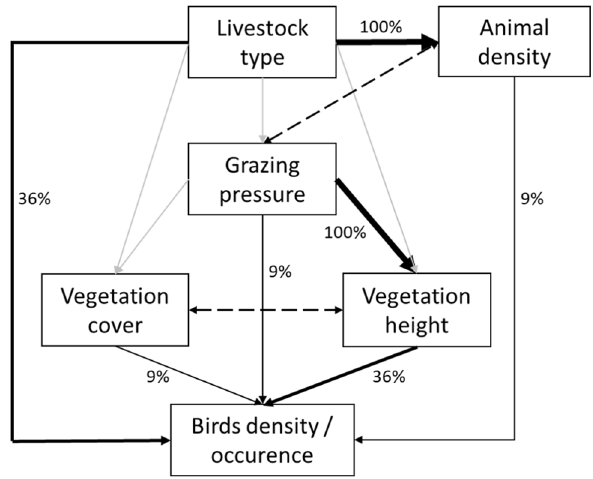
Figure 5. Summary of SEM results for the six bird species density and occurrence, in a total of 11 SEMs. Thickness of the paths is proportional to the number of times that path was significant (< 0.1), regardless of the direction (positive or negative) of the